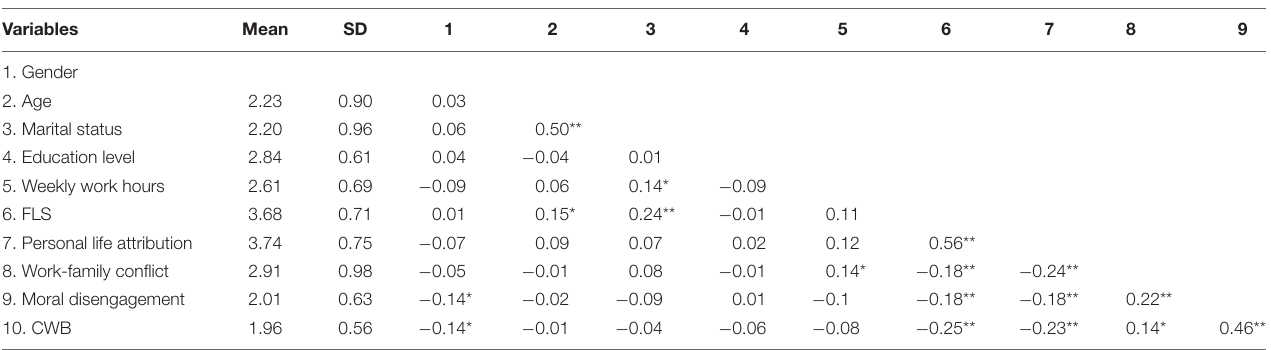
TABLE 2 | Descriptive statistics and correlation analysis ( N = 251).